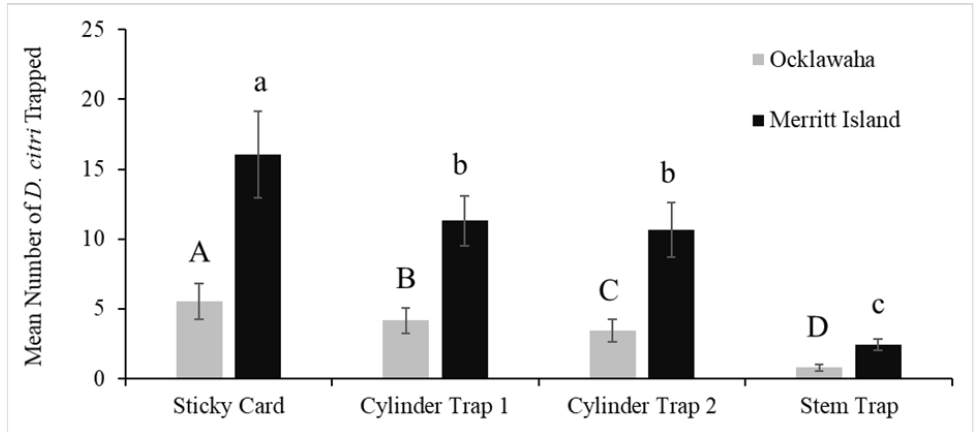
Figure 4. Comparison of ACP capture rates per trap-type in Florida fields using the Poisson test. The three trap-types were deployed in eight blocks per location between 1 May 2018, to 26 June 2018. The number of traps deployed in Merritt Island was 48 and in Ocklawaha was 128. The calcu- lated mean number of psyllids per trap in Ocklawaha were 10.1 for sticky cards, 9.6 for cylinder trap 1 and 1.6 for stem traps. In Merritt Island, the calculated mean numbers were 7.5 for sticky cards, 6.2 for cylinder trap 1 and 0.9 for stem traps. Standard error bars are shown. The use of different letters indicates significant differences in the ACP capture rate within each site (represented by A, B in Ocklawaha and a, b, c in Merritt Island).